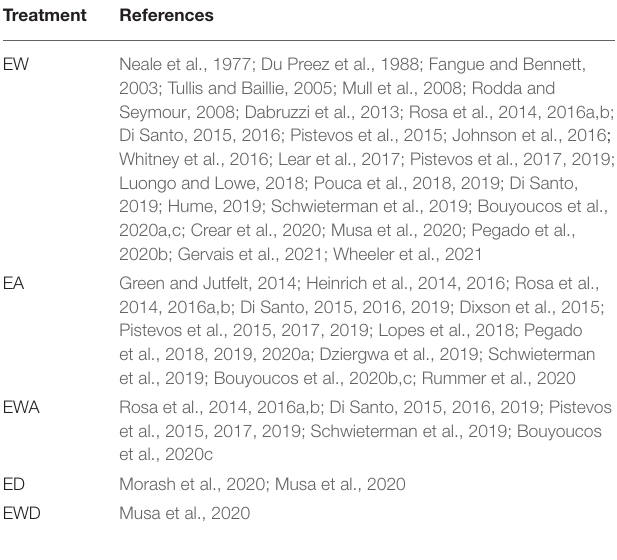
TABLE 1 | Summary of the references including in the analysis across the different treatments, namely experimental warming (EW), acidification (EA), deoxygenation (ED), and their combination (EWA and